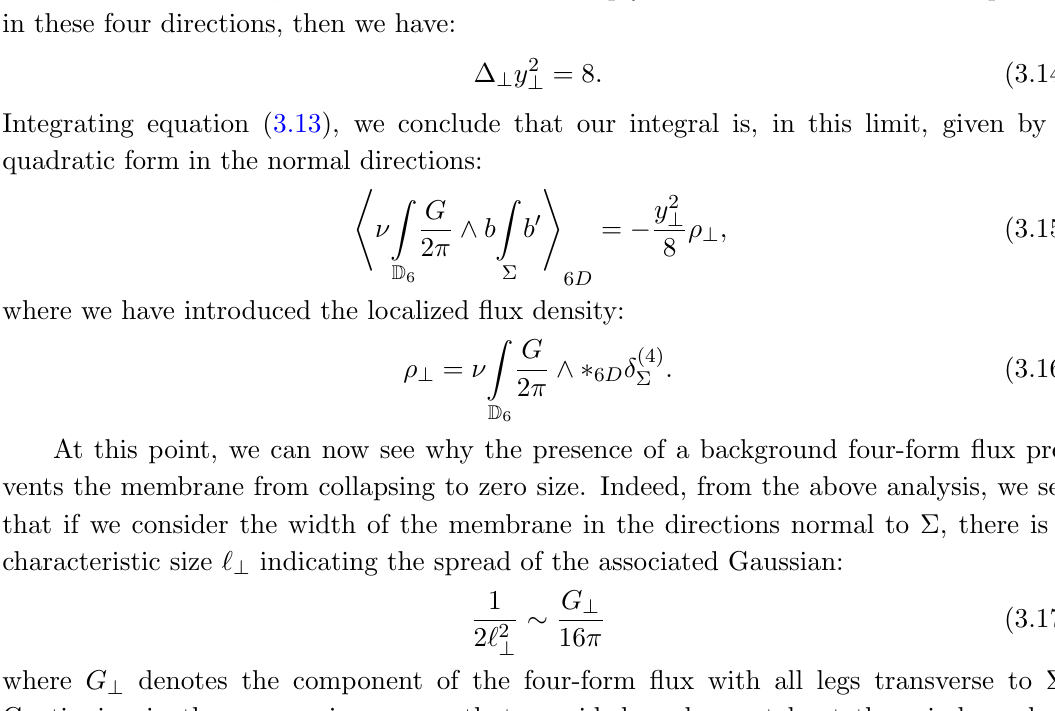
Figure 3 . Depiction of a quantum Hall droplet of characteristic radius (cid:24) 1 =